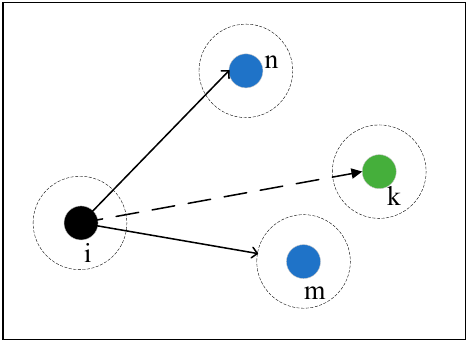
9 of 20 Figure 3. Diagram of non-dominated fronts. The le tt ers A, B and C represent the solution A, B and C. Points of the same color represent solutions in the same dominance fronts. After determining the non-dominated rank of each solution, the crowding distance entropy of each solution is calculated. The solutions are ranked according to their non- dominated rank and crowding distance entropy in the following way: for two individuals with di ff erent non-dominated ranks, the one with a lower non-dominated rank is pre- ferred over the one with a higher non-dominated rank; for individuals with the same dominance rank, the one with larger crowding distance entropy is preferred over the one with smaller crowding distance entropy.